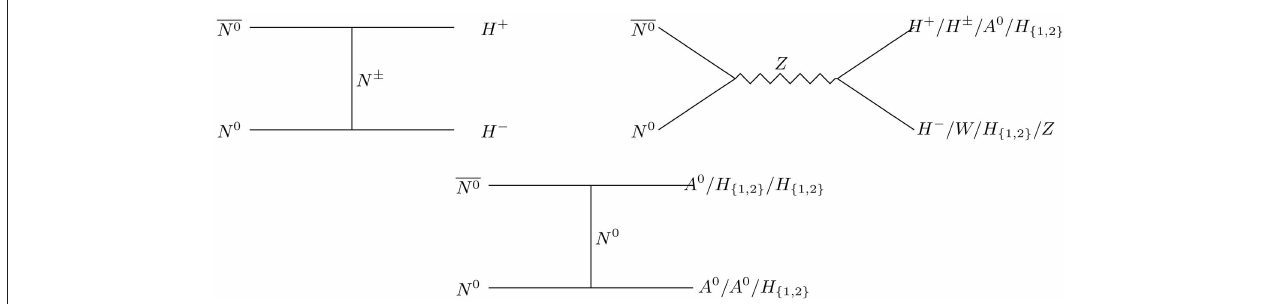
FIGURE 7 | Additional annihilation N 0 N 0 , in presence of scalar